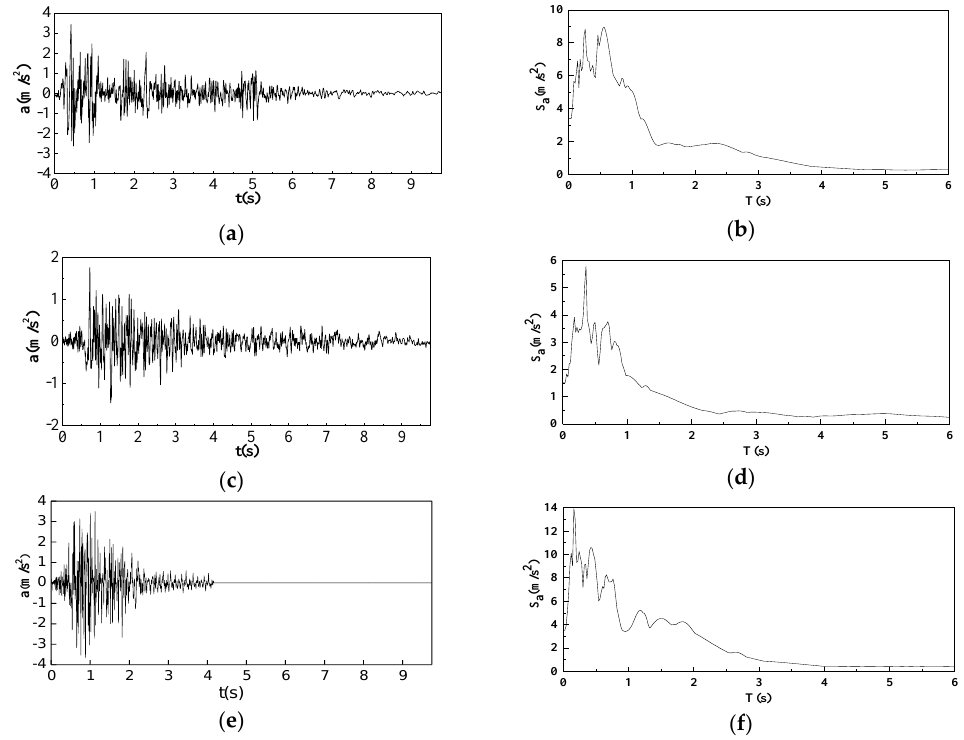
Figure 7. Acceleration curve and response spectrum of three waves. ( a ) Acceleration time history curve of El Centro wave; ( b ) response spectrum of El Centro wave; ( c ) acceleration time history curve of Taft wave; ( d ) response spectrum of Taft wave; ( e ) acceleration time history curve of artificial wave; ( f ) response spectrum of artificial wave.